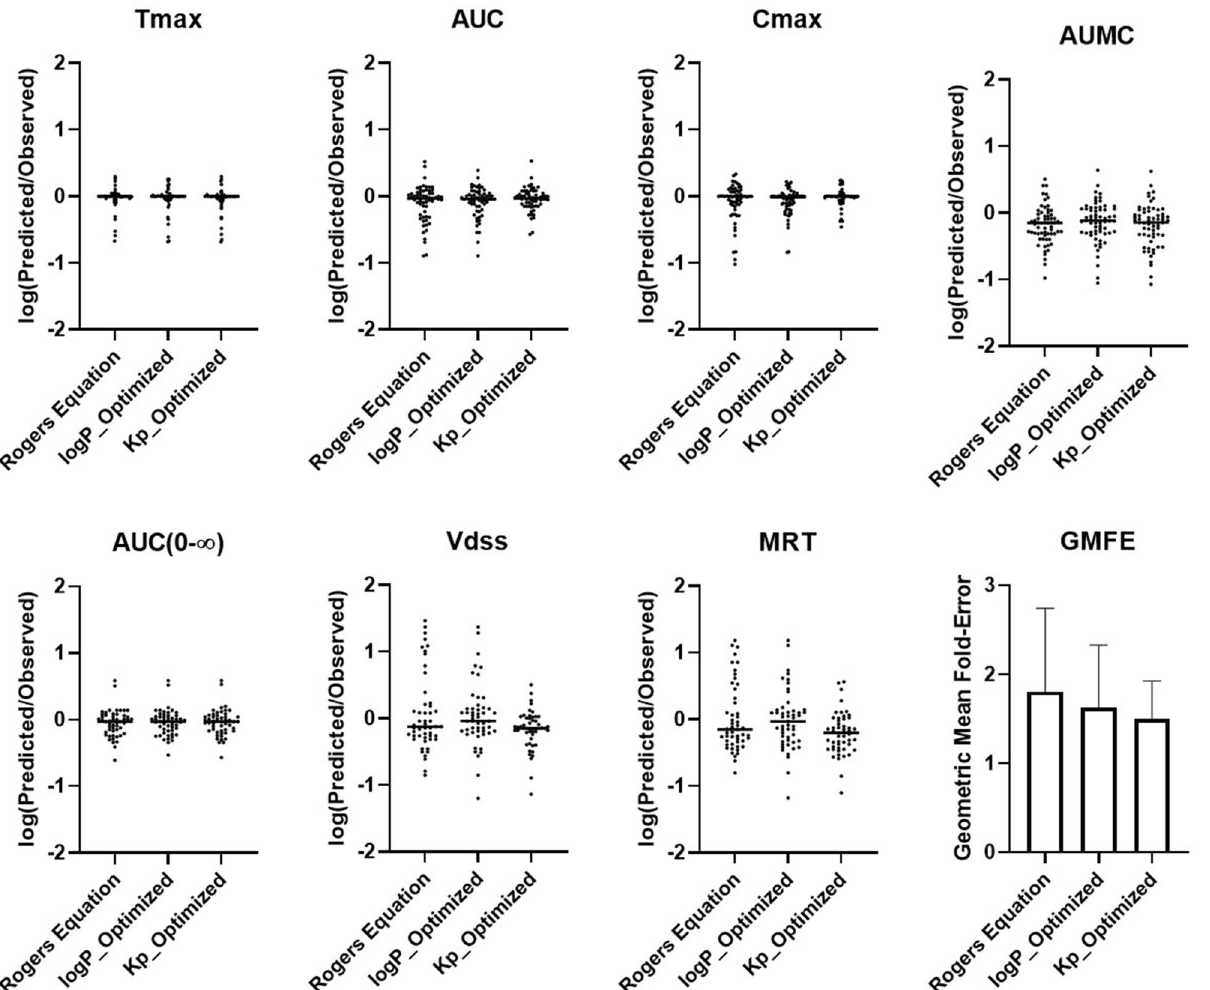
Figure 5. Comparison of the PK outputs fold-difference magnitude and geometric mean fold-error (GMFE) across the three optimization